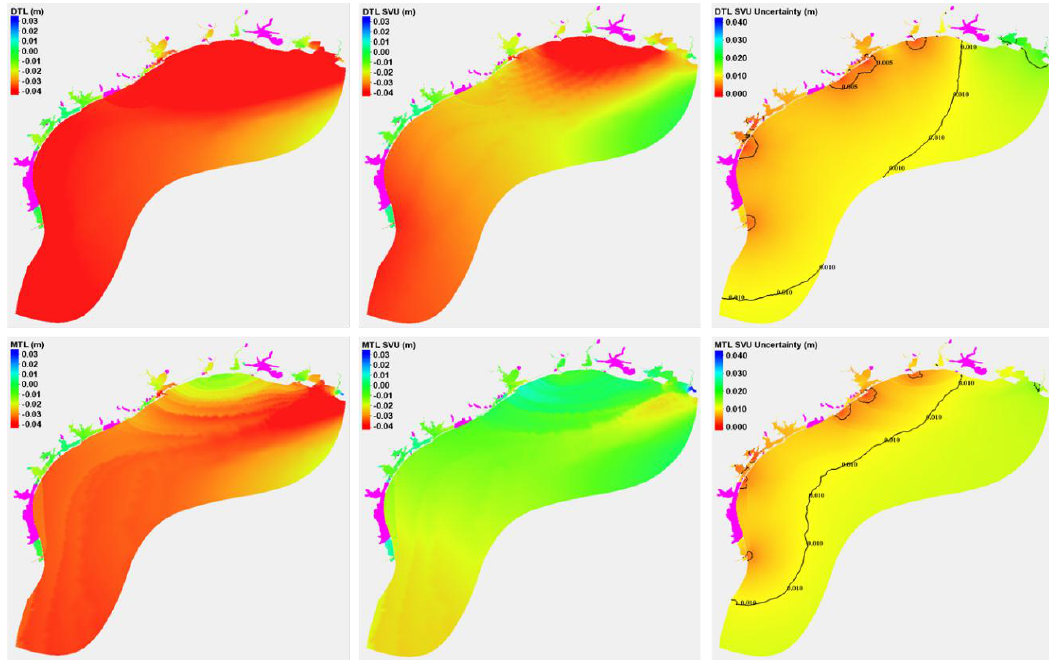
Figure 11. Modeled DTL ( upper row ) and MTL ( lower row ) tidal datums. The first column shows ADCIRC modeled tidal datums; the second column shows the tidal datums after the SVU statistical interpolation; the third column shows the associated SVU spatially varying uncertainties. Model grid points in pink represent the modeled non-tidal grid points (modeled MHW-MLW < 0.09 m).